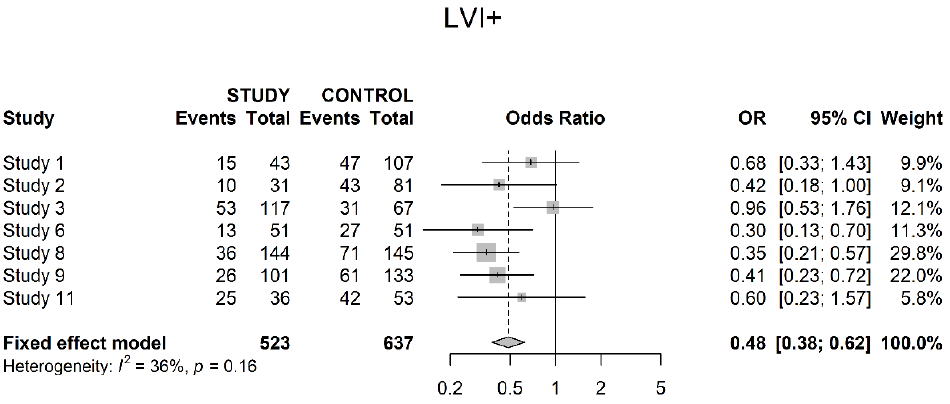
Figure 10. Lymphovascular invasion.